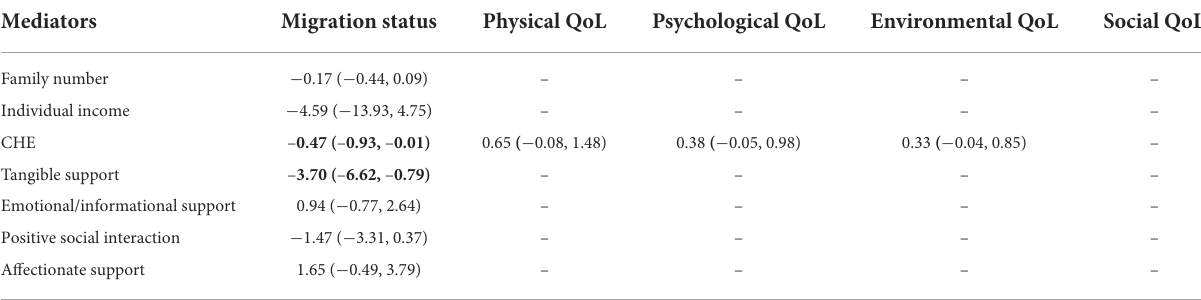
TABLE 6 Indirect effects of migration on the four dimensions of QoL for urban adults with rare